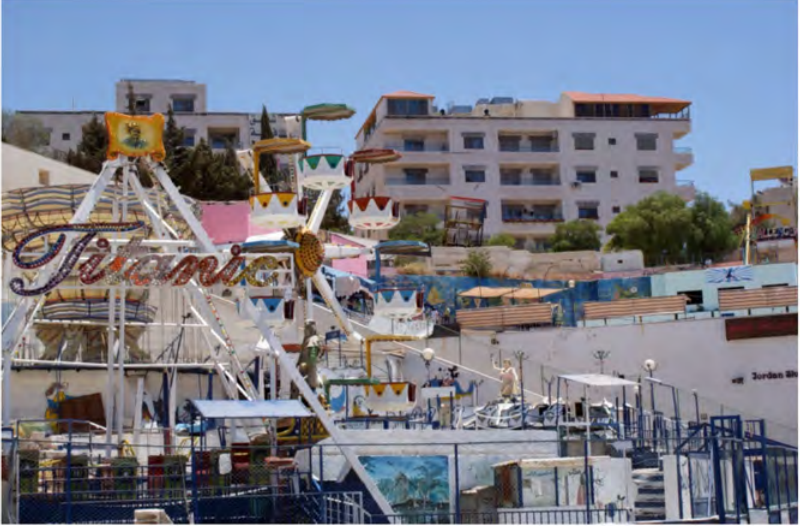
Figure 30. King Abdullah abandoned park. Source: City seeker